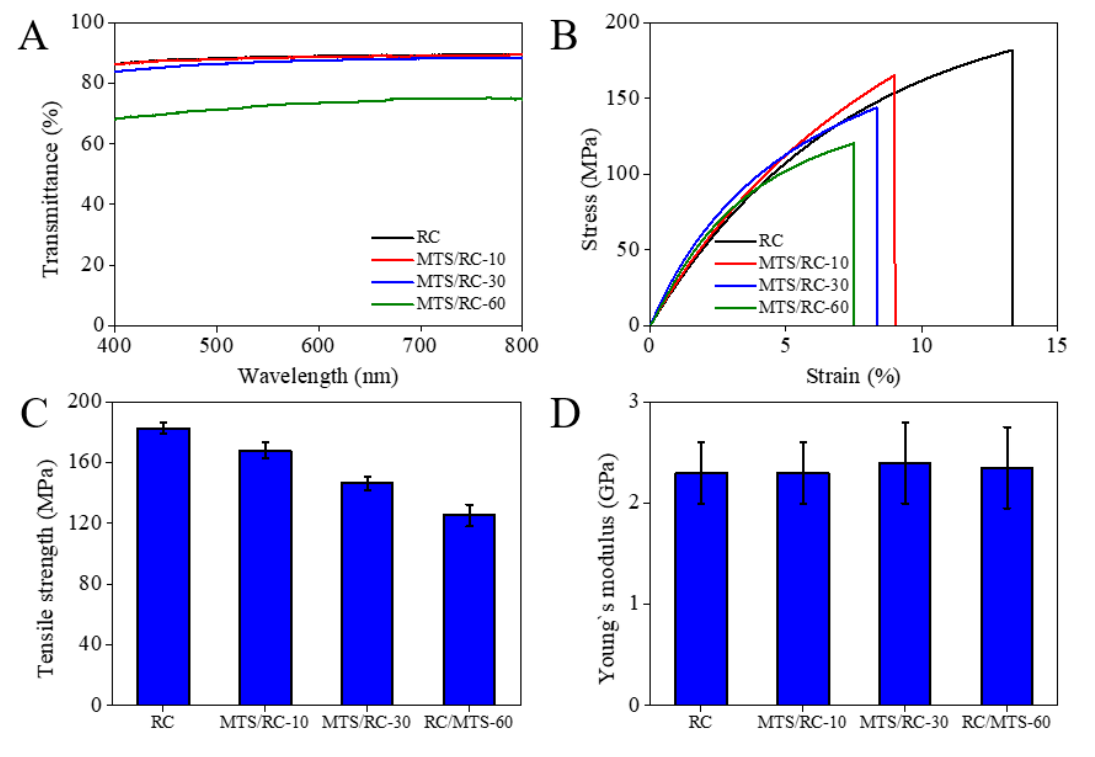
Figure 6. ( A ) Optical transmittance of the pristine RC film and the MTS/RC-10, MTS/RC-30, and MTS/RC-60 films. ( B – D ) Mechanical properties of the pristine RC film and the MTS/RC films. ( B ) Stress–strain curve, ( C ) tensile strength, and ( D ) Young’s modulus of the pristine RC film and the MTS/RC-10, MTS/RC-30, and MTS/RC-60 films.